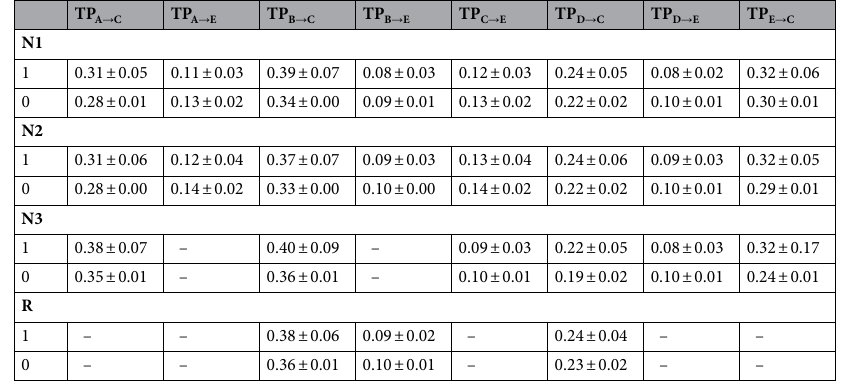
Table 5. Significantly different transition probabilities of 5 microstates in OSA_OH and OSA_withoutOH patients (– indicates no significance in the table).